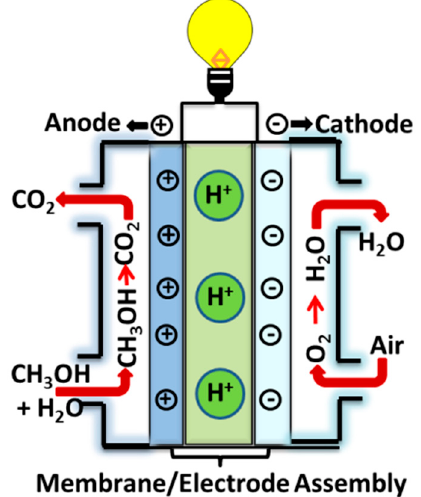
Figure 1. Schematic representation of anodic and cathodic reactions in a typical fuel cell .